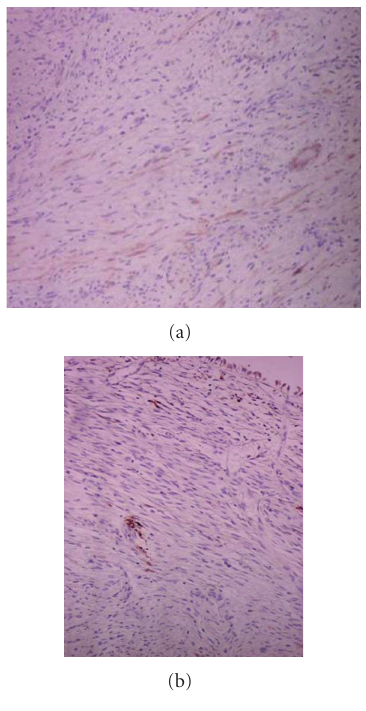
Figure 2: The immunohistochemical staining profile of the tumor (a) APAP/ a-SMA X 25, and (b) APAP/S-100 X